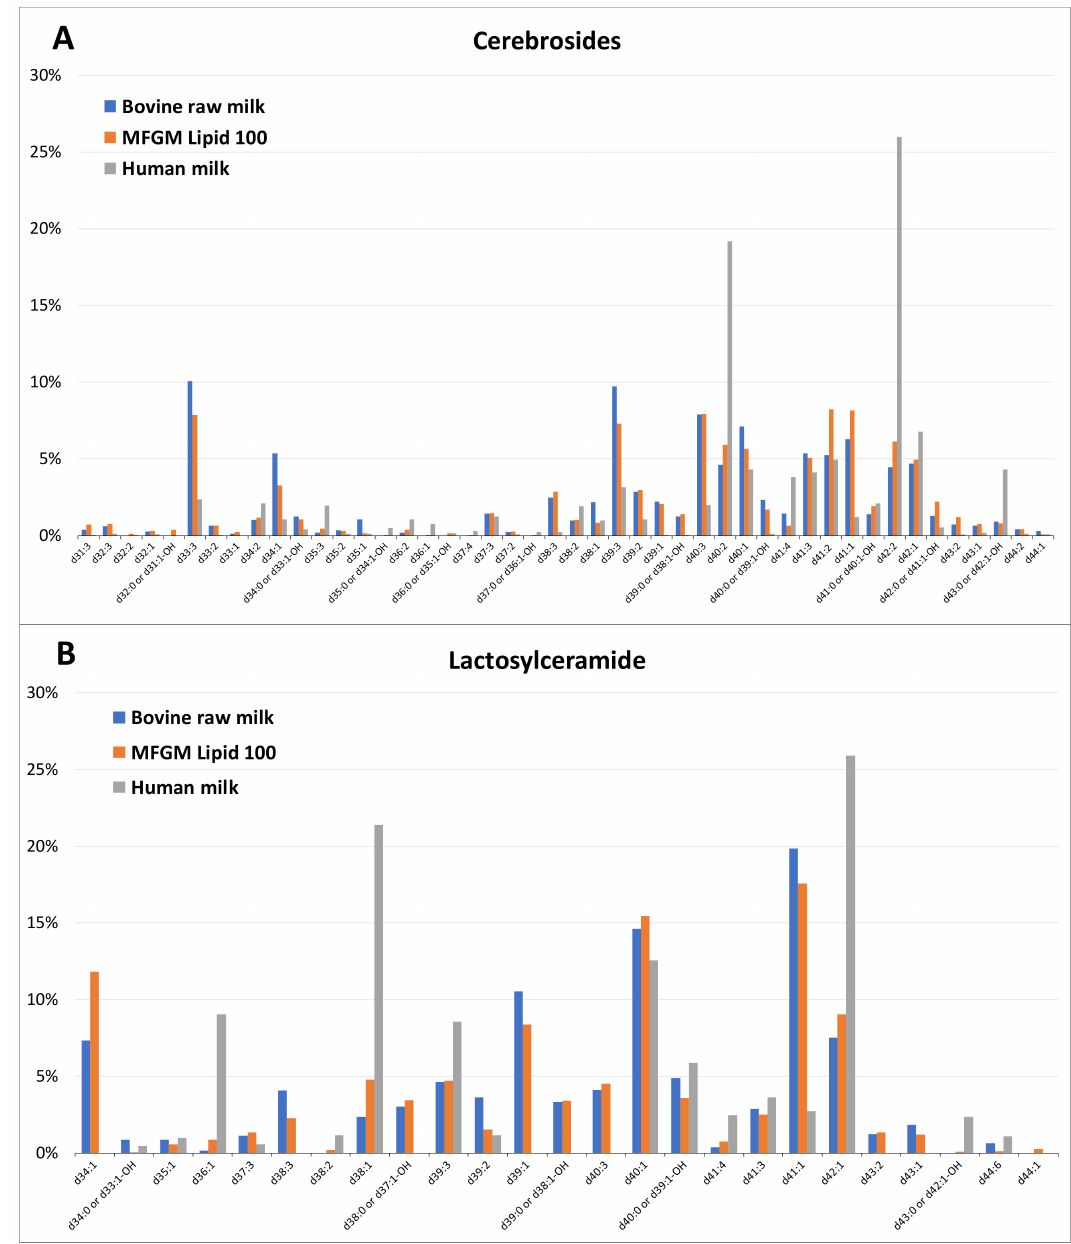
Figure 5. Proportional distribution of the major molecular species (indicated as the “d” number) of Crbs ( A ) and LacCer ( B ) in bovine milk, MFGM Lipid 100 and human